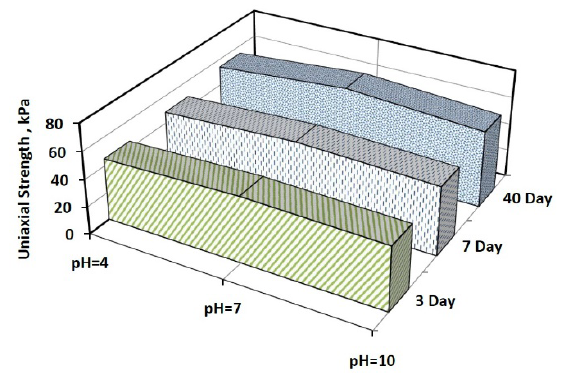
Figure 8: Unconfined compressive strength of nonstabilized samples in various environments in terms of acidity.